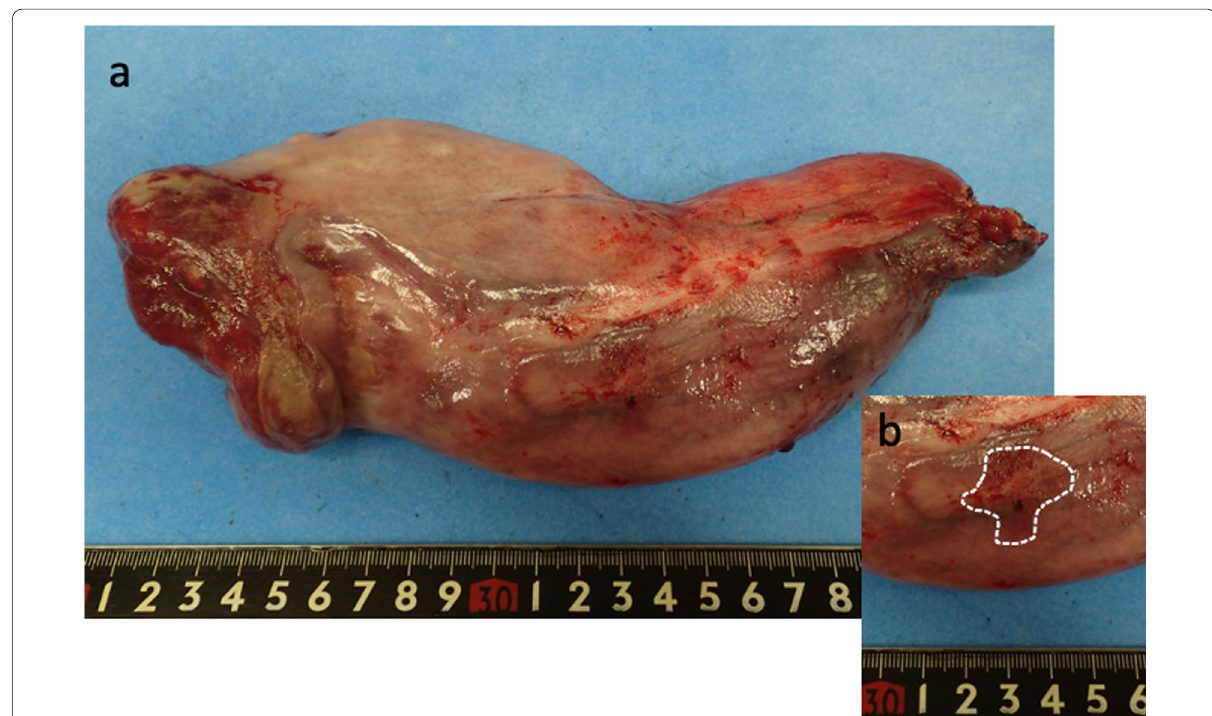
Fig. 4 The excised specimen. a Overview of a 23.0